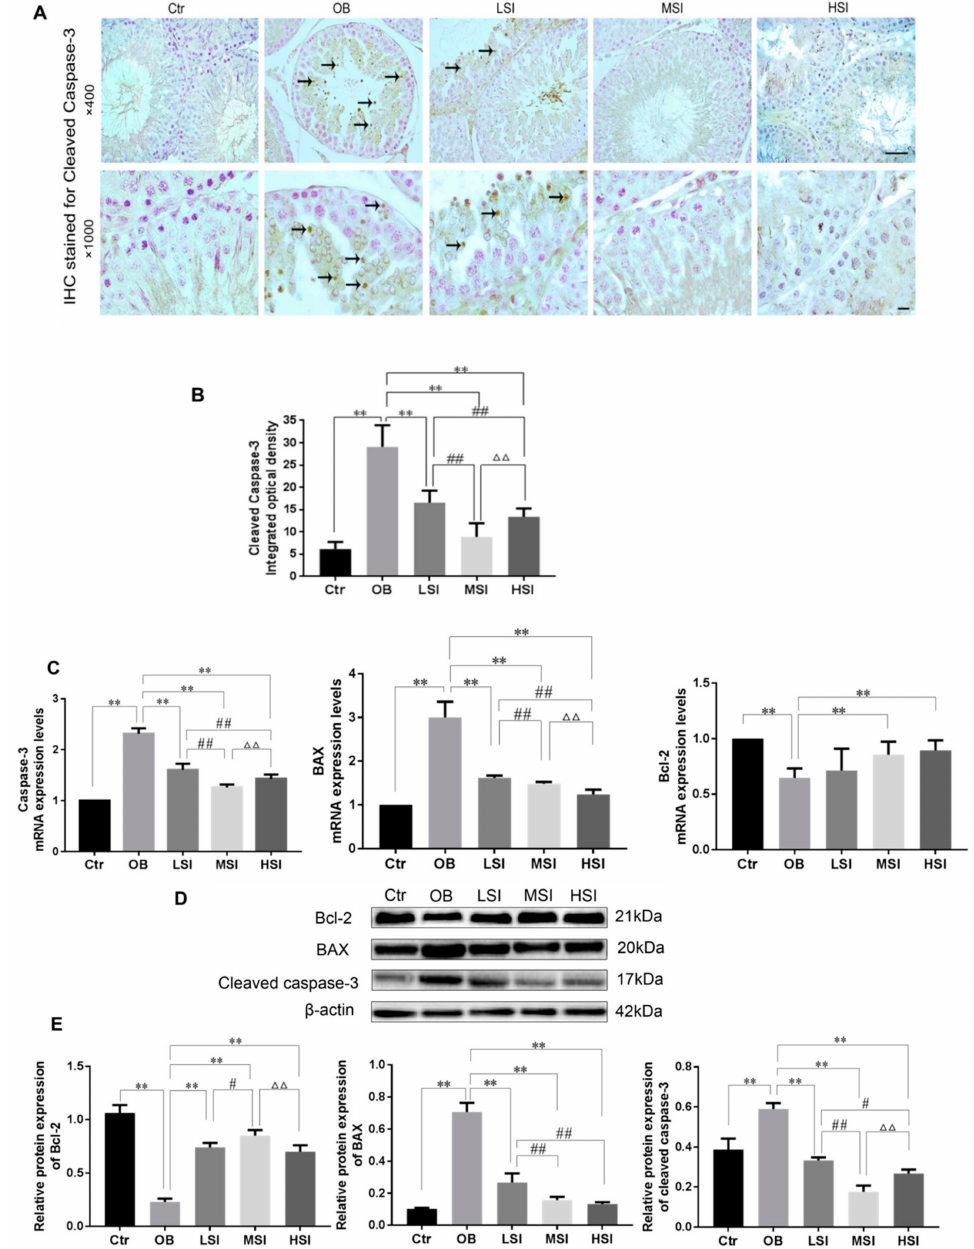
Figure 6. SIF reduced excessive apoptosis of testicular germ cells in obese rats by increased levels of Bcl-2 and decreased levels of BAX and caspase-3. ( A ) IHC detection of cleaved caspase-3 expression in testicular tissue. Cleaved caspase-3 positive and negative cells were stained in brown colored and bluish violet, respectively. Black arrowheads: Cleaved caspase-3 positive cell. Magnification: 400 × ; scale bar: 50 µ m. Magnification: 1000 × ; scale bar: 10 µ m. ( B ) IOD of cleaved caspase-3 protein expression in the testis. ( C ) mRNA expression level of Bcl-2,BAX and caspase-3 in the indicated groups ( n = 8). ( D , E ) proteins expression level of Bcl-2, BAX and cleaved caspase-3 in the indicated groups ( n = 8). Bars represent the mean ± SD, * p < 0.05, ** p < 0.01 vs. OB; # p < 0.05, ## p < 0.01 vs. LSI; ∆ p < 0.05, ∆∆ p < 0.05 vs. MSI, one-way ANOVA analysis and LSD